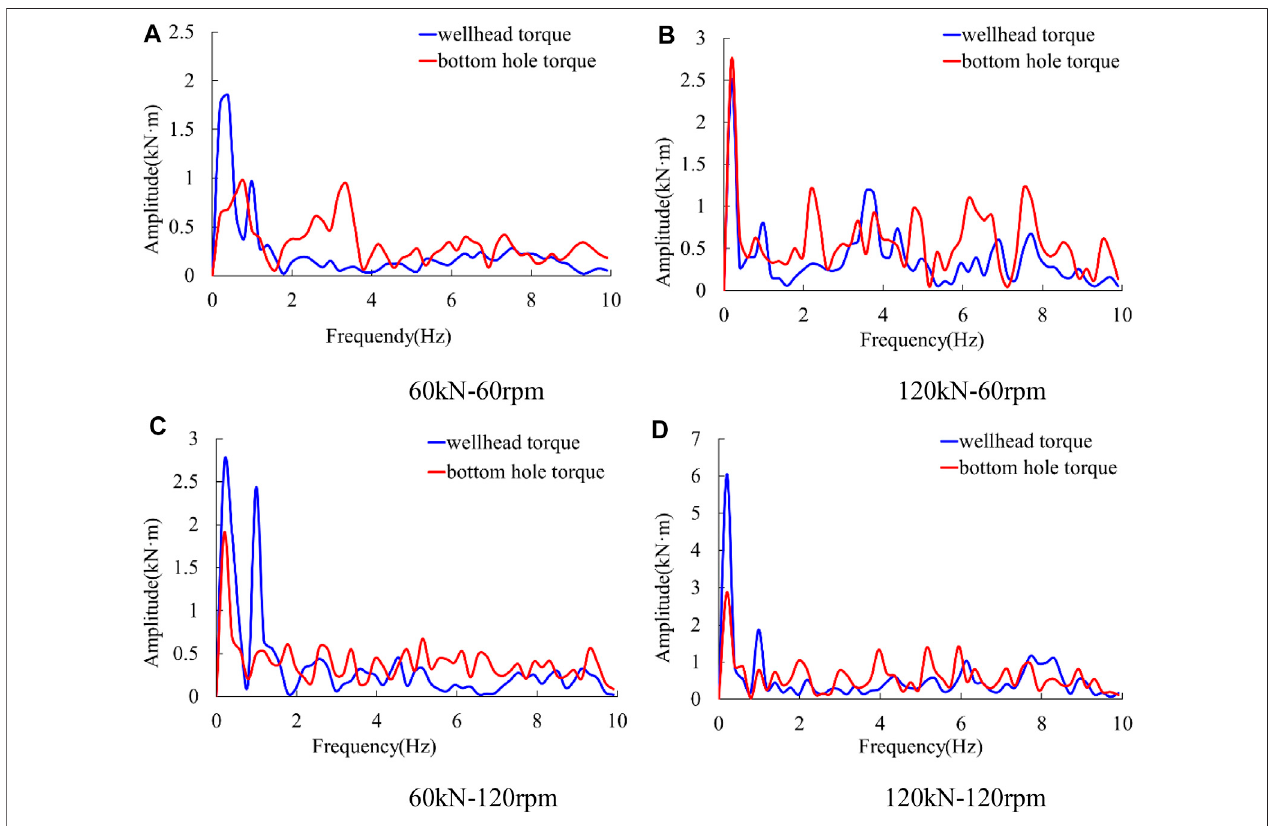
FIGURE 18 | Frequency spectrums of